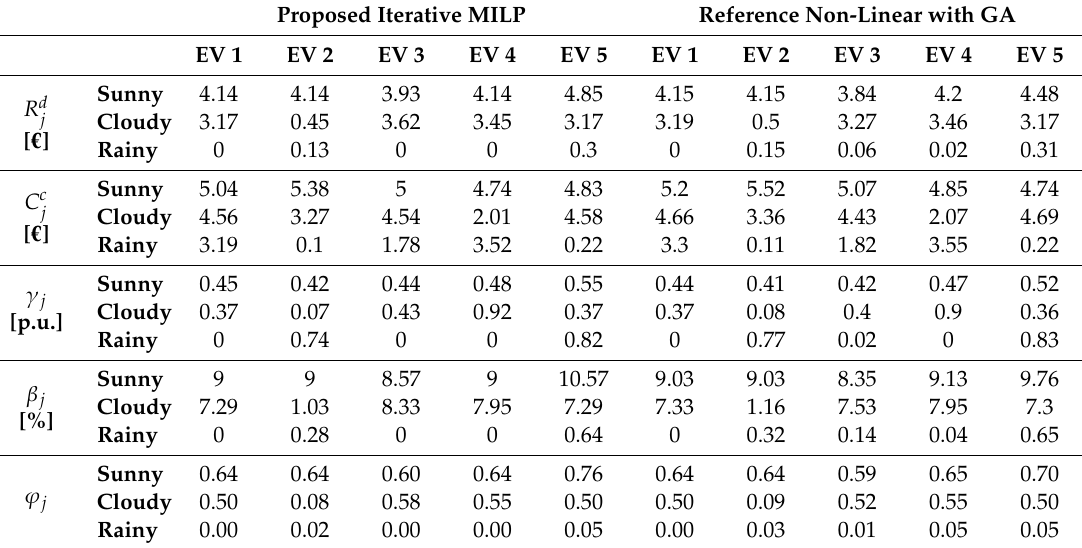
Table 3. Techno-economic performances of EVs for the three typical days. Proposed Iterative